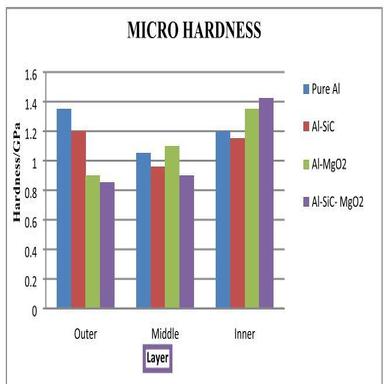
Variation of compressive strength with respect to variation in the layers.